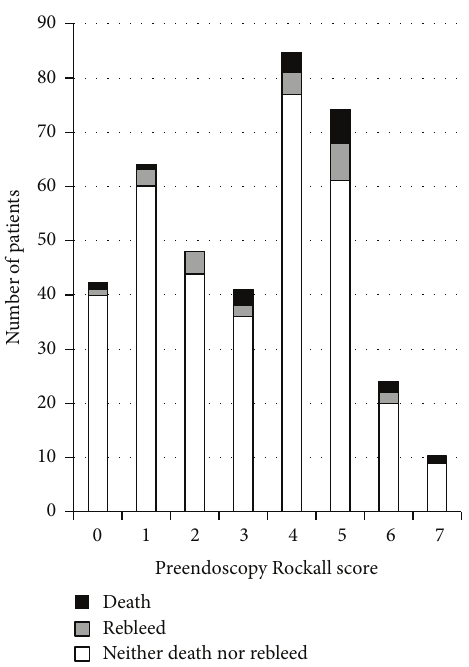
Figure 3: Preendoscopy Rockall score (PERS) for 388 consecutive patients admitted with upper gastrointestinal haemorrhage over 5 years (2006–2011). The overall 30-day mortality was 4.6% with a 14- day rebleed rate of